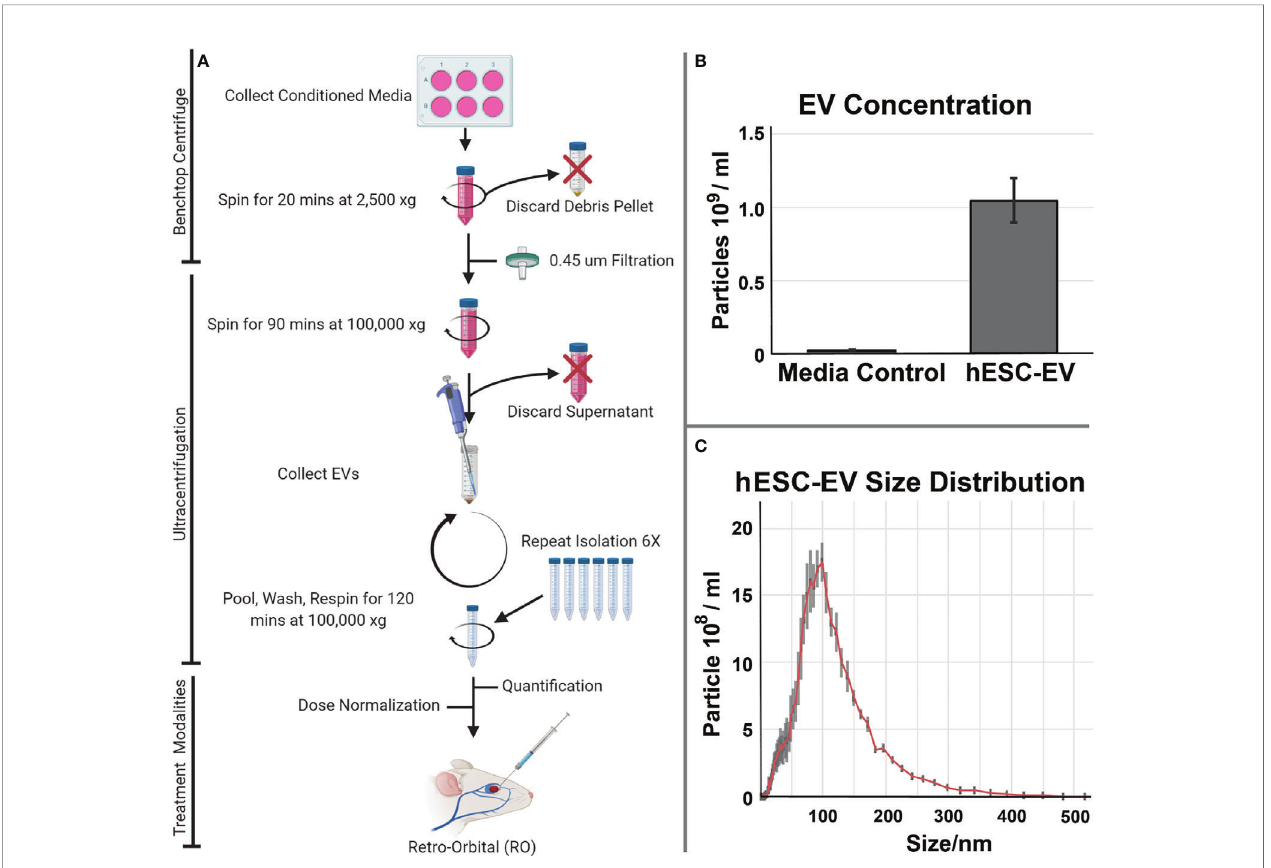
FIGURE 1 | Isolation and characterization of hESC-derived EV isolation and administration. (A) Conditioned medium collected from cultures of hESC or hNSC) were processed by ultracentrifugation for the isolation and quanti fi cation of EV. EV were subsequently delivered as systemic, retro-orbital (RO) injections to evaluate their potential therapeutic ef fi cacy in resolving radiation-induced injury to the lung. EV isolated from the serum alone or those from actual hESC cultures were subjected to the isolation and puri fi cation protocol described. (B) Media accounted for a trace fraction (< 4%) of the total hESC-derived EV used in these studies. Mean EV concentration ± SD. (C) Size distribution of hESC-derived EV reveals a prominent exosome peak at 100